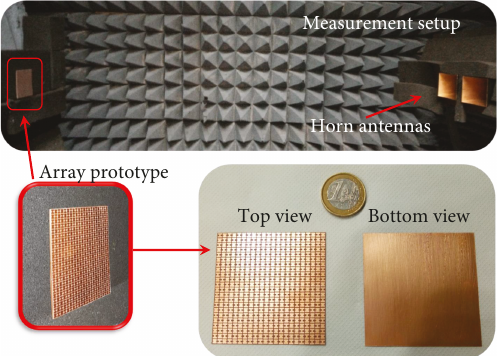
Figure 14: Re fl ection phase measurement setup and the dual-band array